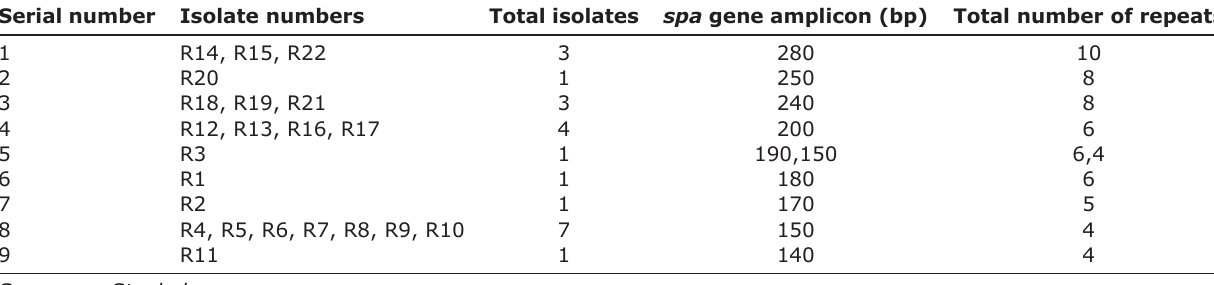
Table-2: spa gene (X-region) polymorphism in S. aureus isolates from Rathi cattle with subclinical mastitis.